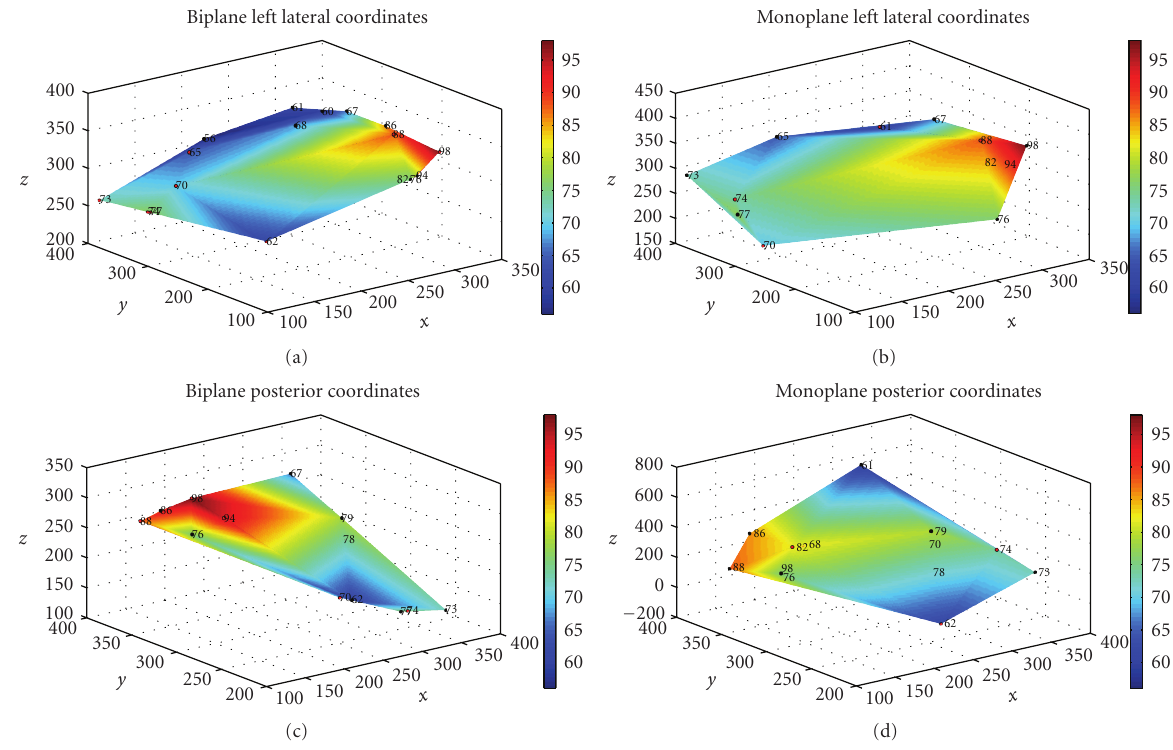
Figure 14: (a), (c) Biplane ground-truth convex hull for left lateral view and posterior view respectively. (b), (d) Single-view 3D estimations of the left ventricle using the convex hull algorithm. We note that the posterior volume estimation is less precise compared to ground